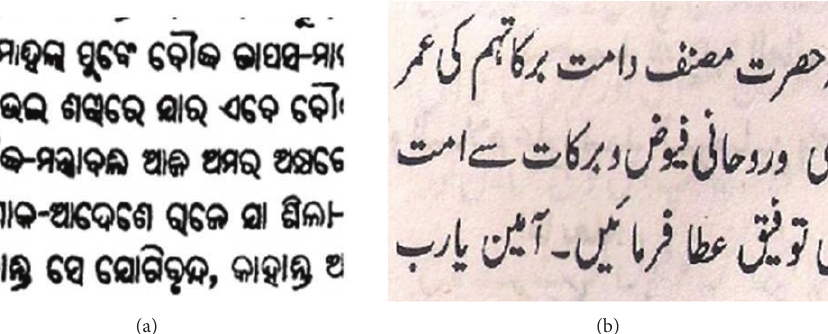
Figure 12: Few of the misclassified instances are shown for different classifiers: (a) Oriya misclassified as Malayalam, (b) Urdu misclassified as Kashmiri.